Question: What visual encoding does this figure use to show its data?
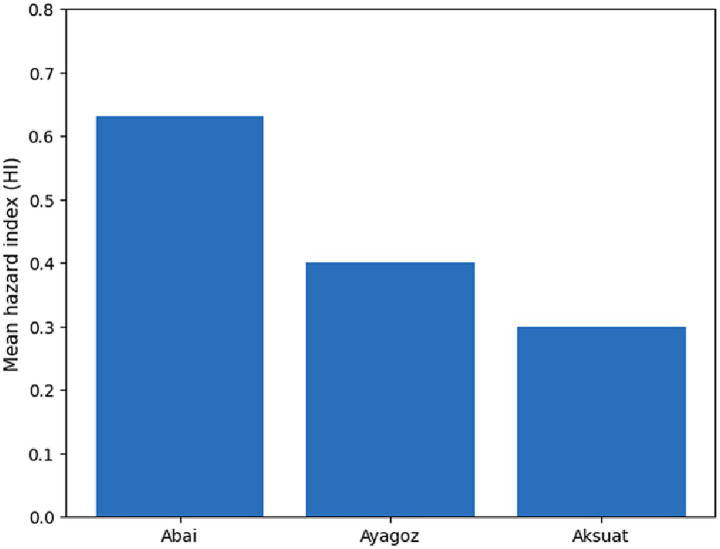
Answer: bar